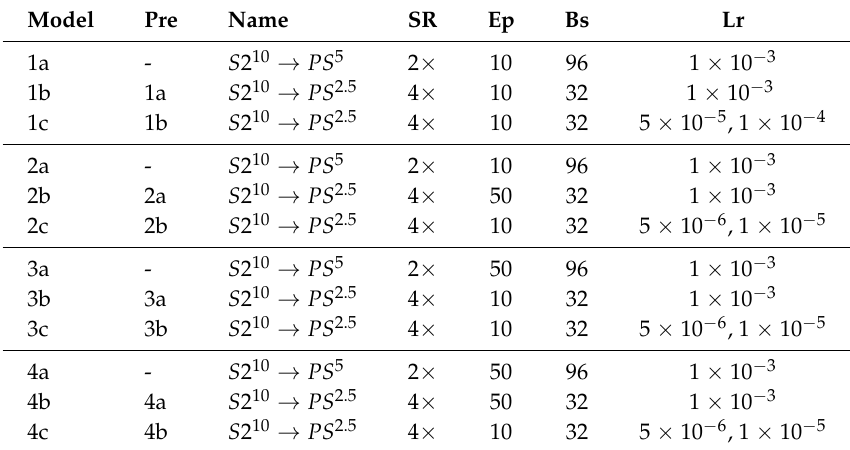
Table 6. Parameters considered in the progressive resizing experiments with